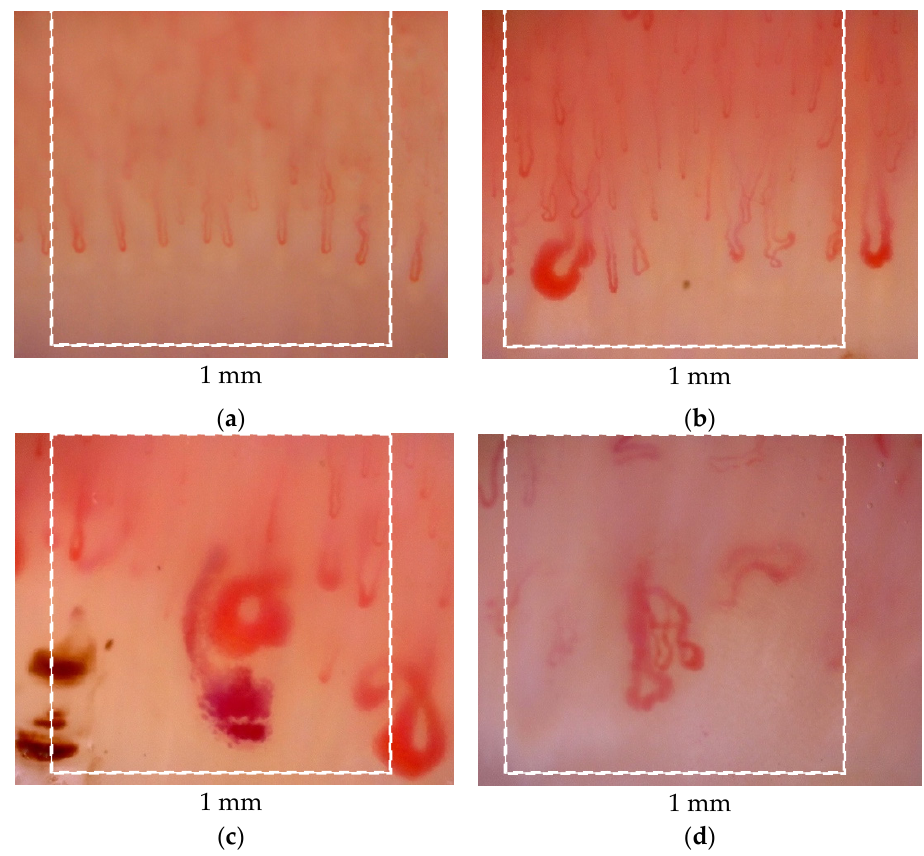
Figure 2. Nailfold videocapillaroscopic (×200) patterns of microangiopathy: ( a )—normal; capillaroscopic characteristics: density—normal, 8 capillaries in 1 linear mm; dimension: within normal limits; morphology: normal shapes of capillaries; haemorrhages: absent ( b )—early; capillaroscopic characteristics: density—7 capillaries in 1 linear mm; dimension: presence of giants (homogeneous enlargement of all three limbs of the capillary with the diameter ≥ 50 µm); morphology: hairpin shaped capillaries; haemorrhages: absent ( c )—active; capillaroscopic characteristics: density—lowered, 4 capillaries in 1 linear mm; dimension: presence of giants (homogeneous enlargement of all three limbs of the capillary with the diameter ≥ 50 µm); morphology: presence of abnormally shaped capillary; haemorrhages: present ( d )—late capillaroscopic characteristics: density—lowered, 2 capillaries in 1 linear mm; dimension: not measured because of presence of abnormal shape; morphology: presence of abnormally shaped capillary; haemorrhages: absent.